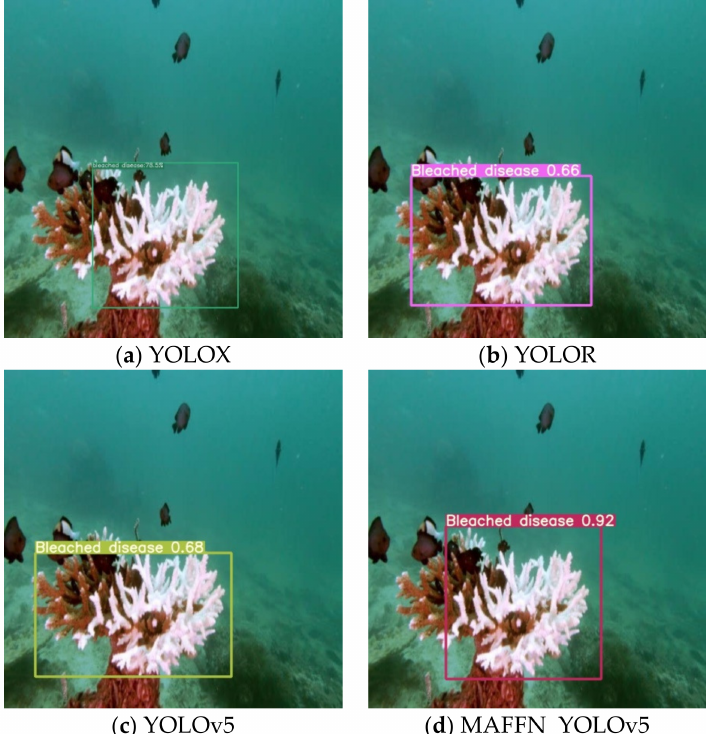
Figure 24. Bleached disease detection.